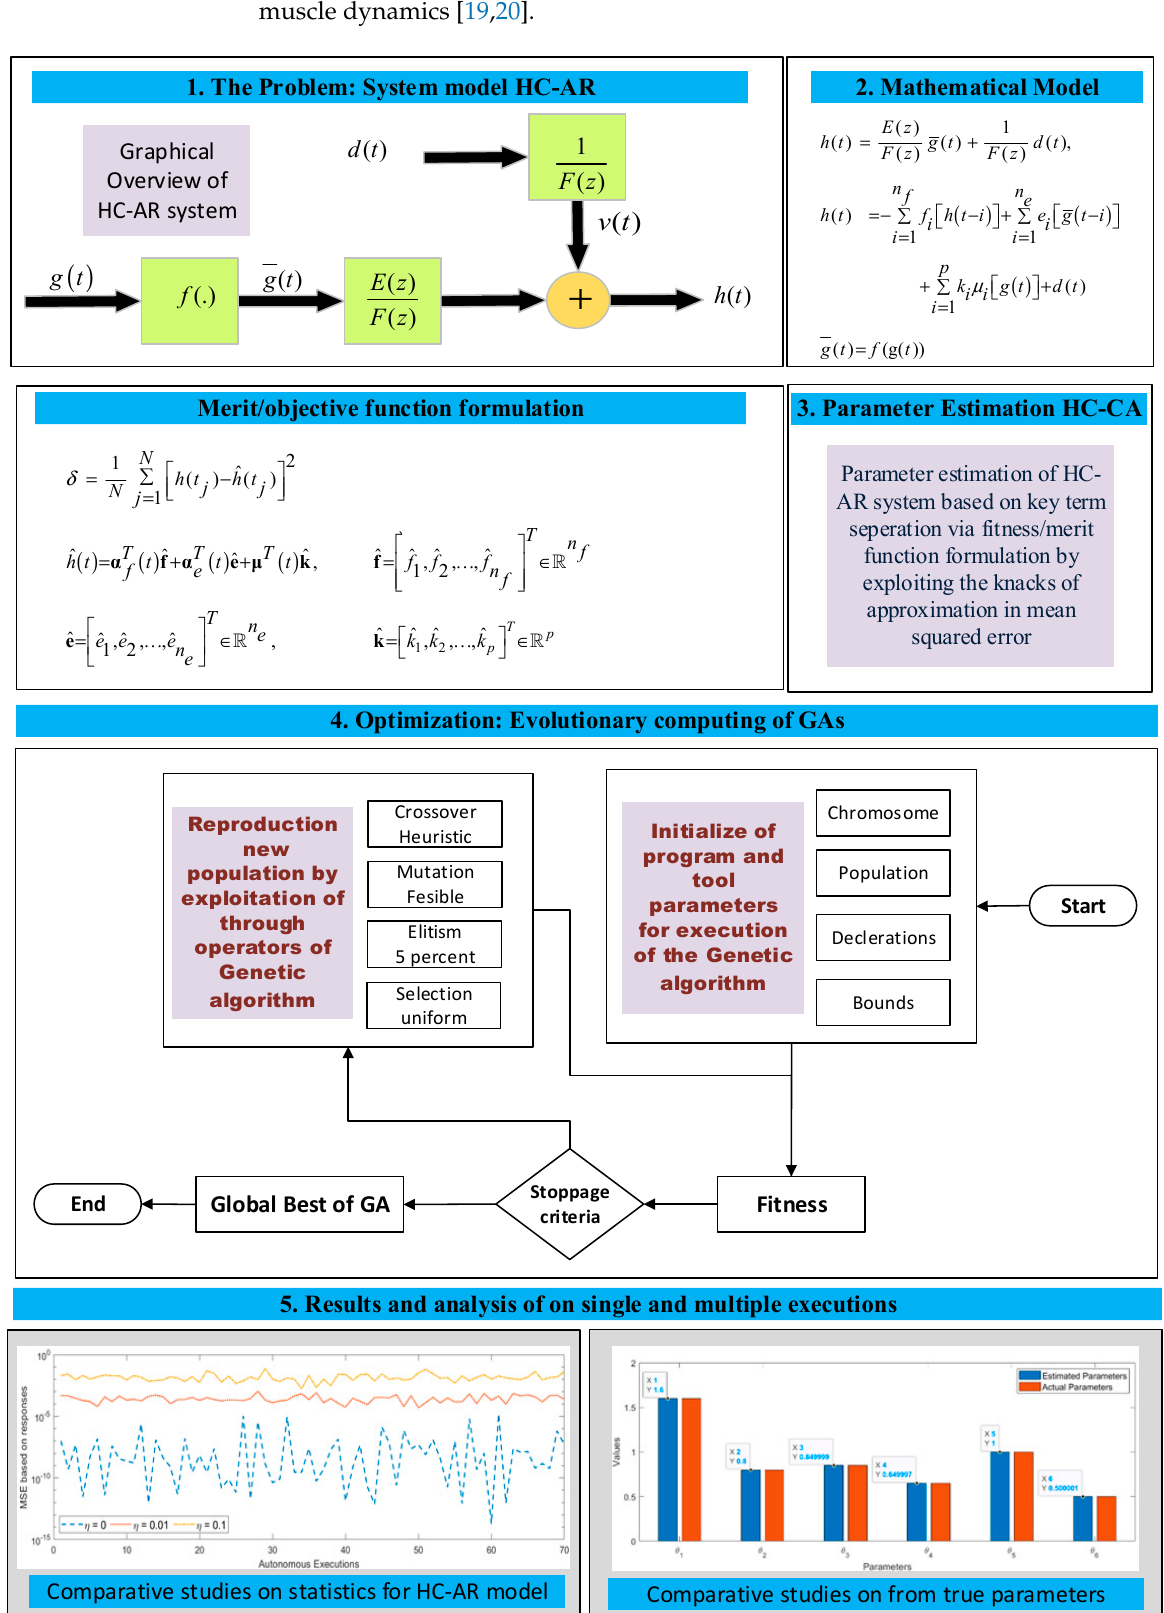
Figure 1. Workflow of methodology for HC-AR systems with evolutionary heuristics of GAs.